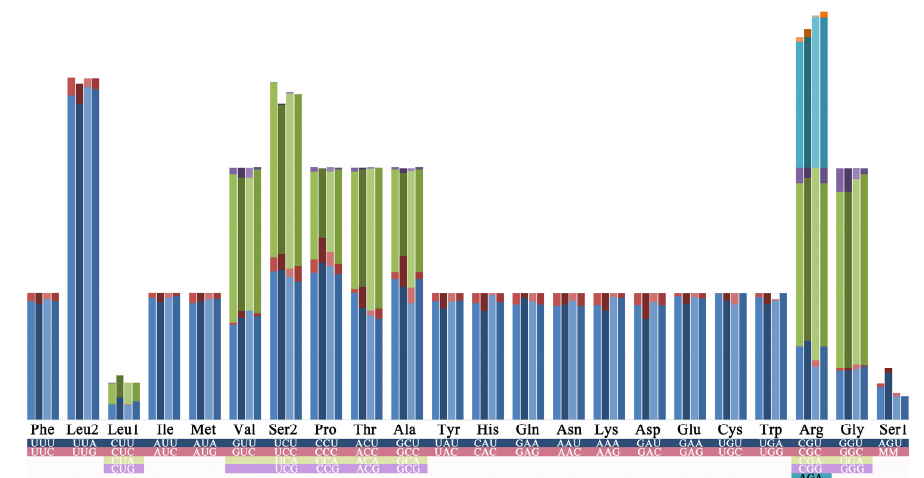
Figure 2. Relative synonymous codon usage (RSCU) of the Megabelesesinae mitogenomes. The RSCU values are shown as the accumulative bar diagrams; from left to right, column shows Megabeleses magnoliae , M. liriodendrovorax , Cladiucha punctata , and C. magnoliae , respecitively. The accumulative bar diagrams of codon families are provided on the x -axis.